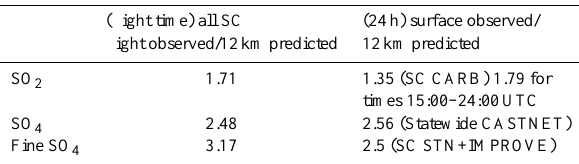
Table 4. Ratios of observed and the 12km simulated SO x . (flight time) all